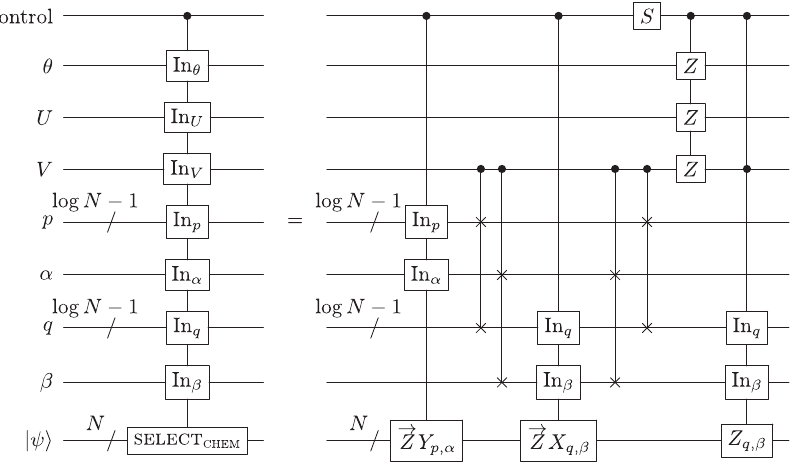
FIG. 14. SELECT circuit, with a T count of 12 N þ 8 log N þ O ð 1 Þ , which implements the functionality specified by Eq. (44), CHEM conditioned on a “ control ” qubit. The unitaries performing Majorana and indexed operations (each requiring 4 N T gates) are explicitly constructed in Sec. III A. As described in Fig. 9, the unitaries labeled as depending on the value from the input j p i register. These operations require an extra log N ancillae, so the overall circuit spans N þ 3 log N þ O ð 1 Þ qubits. The operation that targets the system register with Z All indexed operations reuse the same